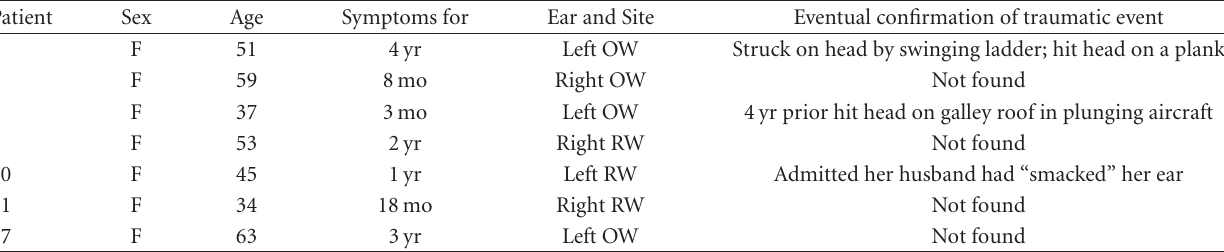
Table 3: Eventual cause found in seven confirmed PLF patients without a trauma